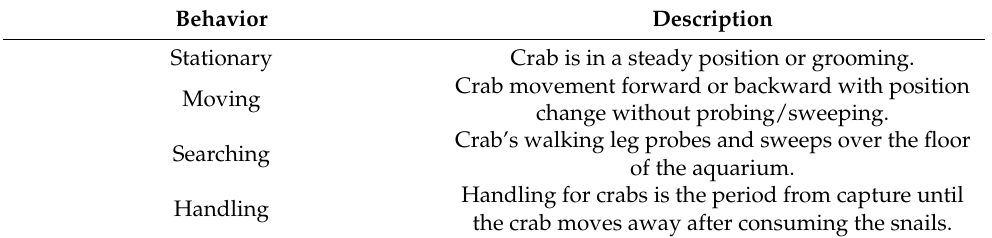
Table 1. Ethogram of foraging behavior of Eriocheir sinensis , adapted from Barbeau and Scheibling [23]. Behavior Description Stationary Crab is in a steady position or grooming. Crab movement forward or backward with position Moving change without probing/sweeping. Crab’s walking leg probes and sweeps over the floor Searching of the aquarium. Handling for crabs is the period from capture until Handling the crab moves away after consuming the